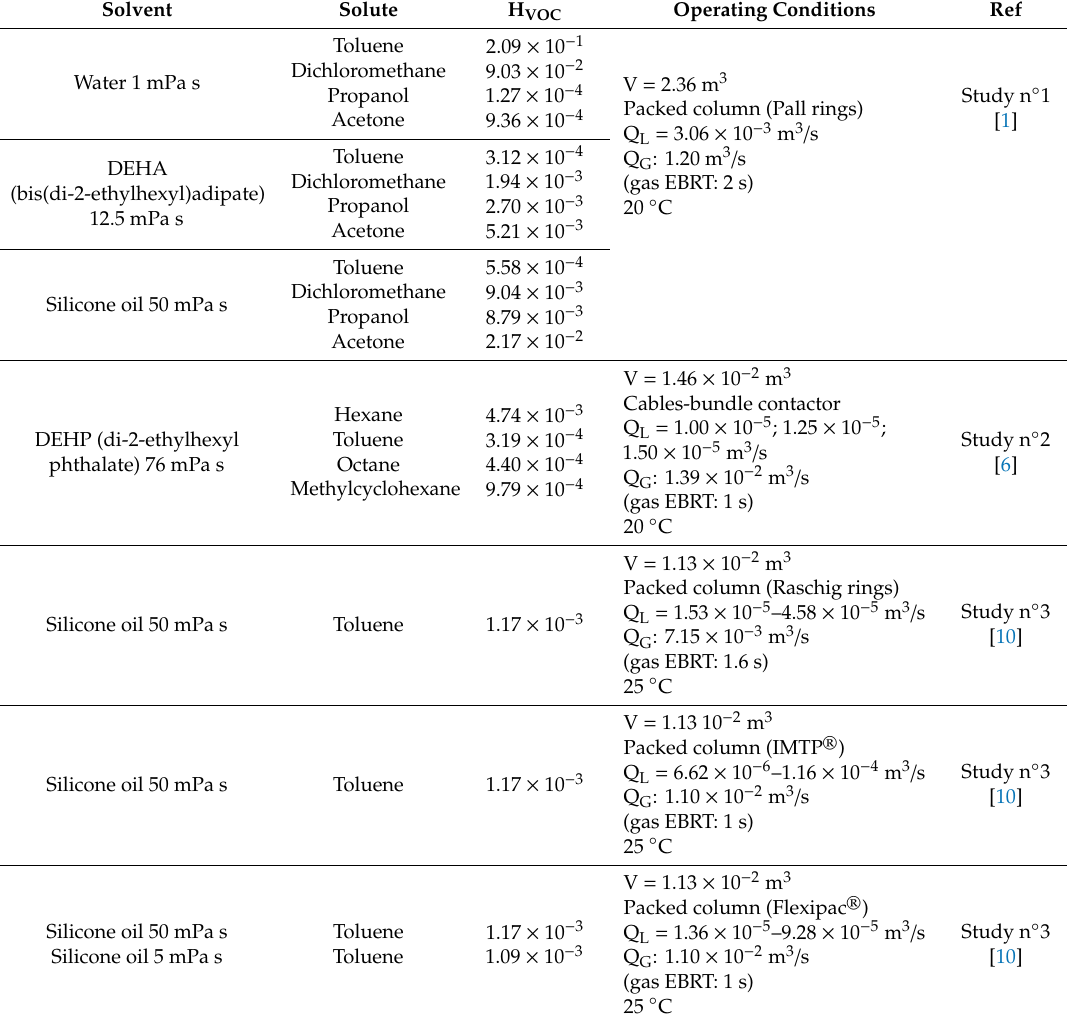
Table 2. Literature data used for the K L a determination using the ε -NTU